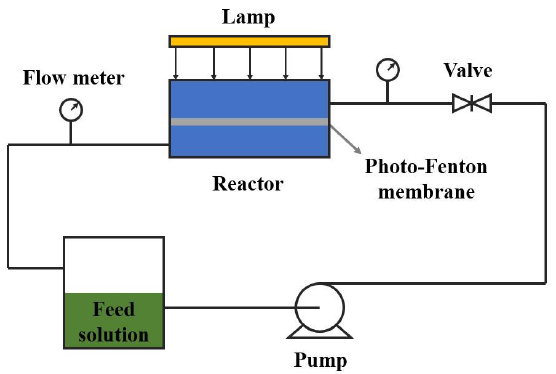
Figure 1. Schematic diagram of common immobilized reactors.